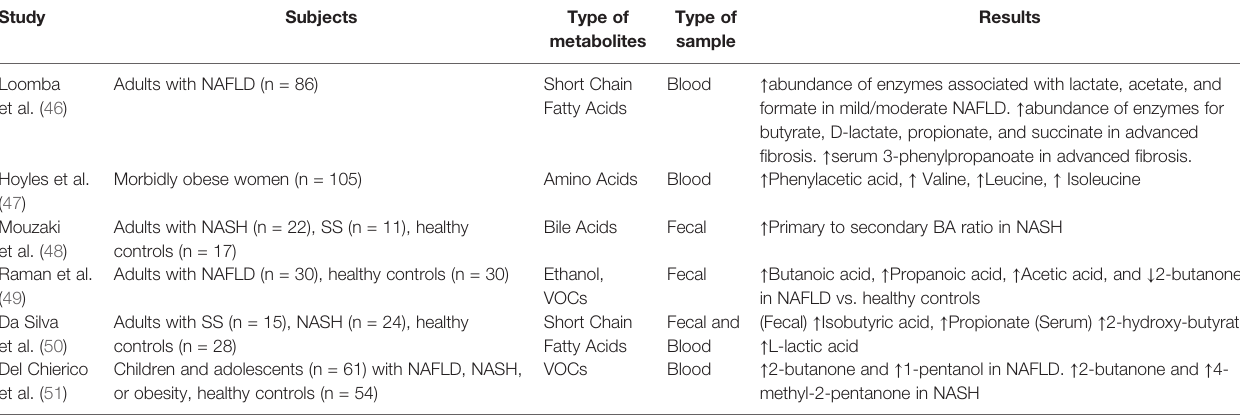
TABLE 1 | Examples of human studies on the gut microbiota-derived metabolites in NAFLD and NASH. Study Subjects Type of